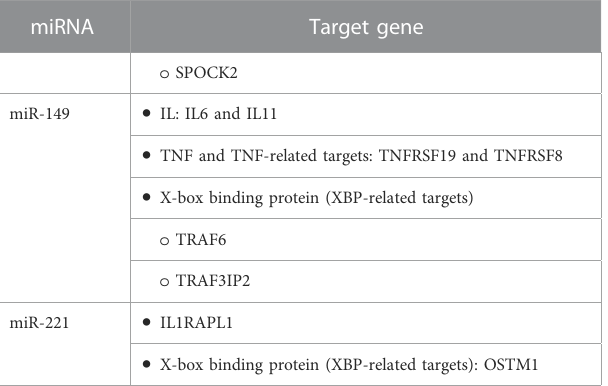
expressed miRNAs in the human umbilical vein endothelial cells (Poliseno et al., 2006).